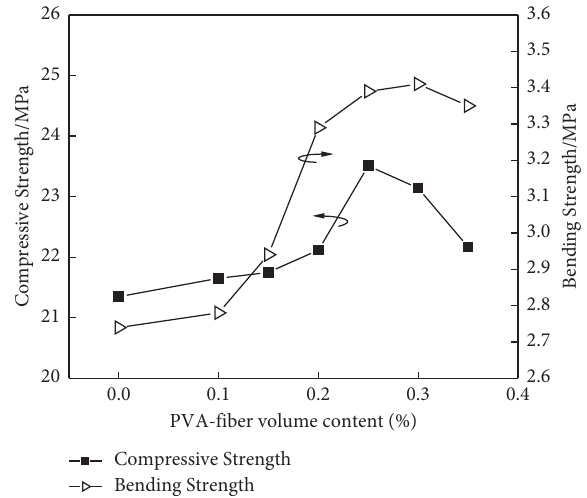
Figure 7: Black and white binarized section of RCCA type U-type branch